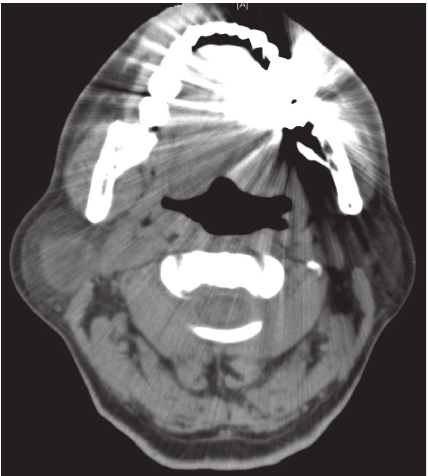
Figure 2: CT with contrast revealed an enhancing multilocular cystic lesion in the right parotid